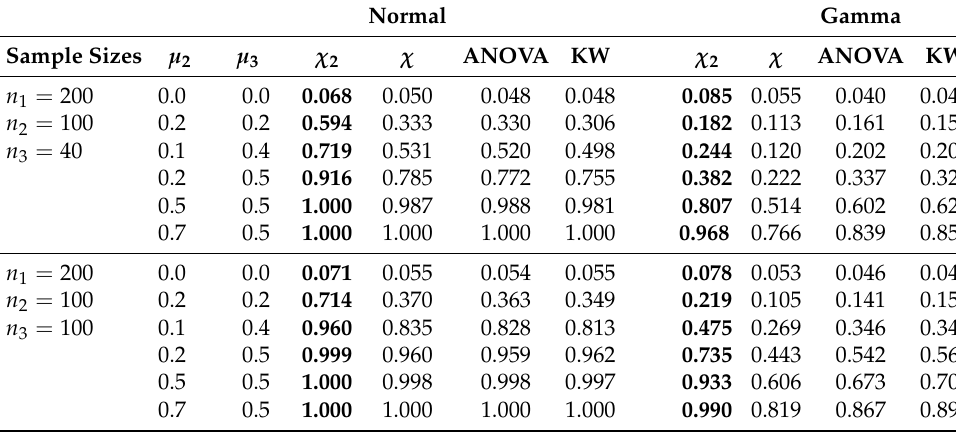
Table 3. Power comparison with different sample